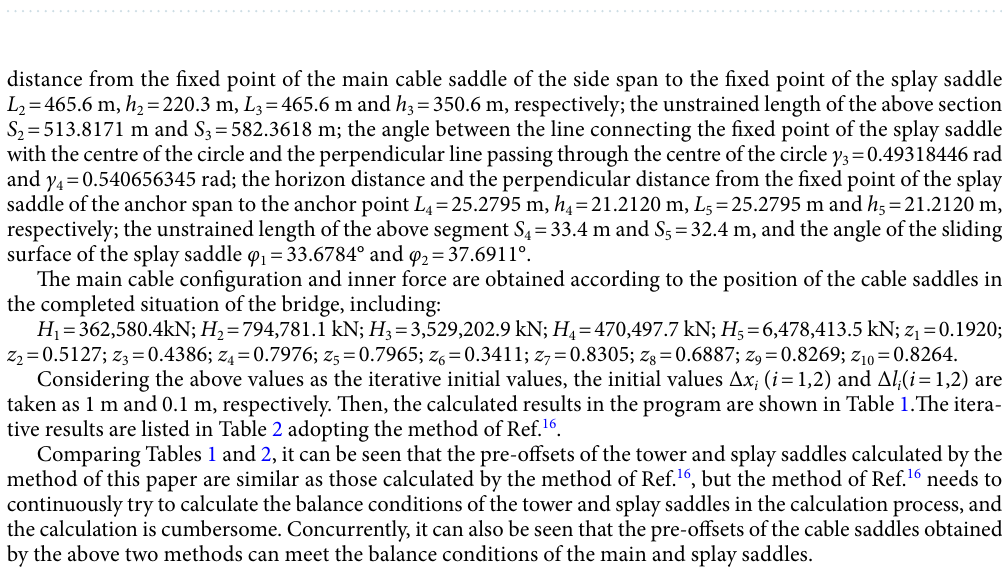
Table 2. Results of cable saddle pre-offsets adopting the method of Ref. 16